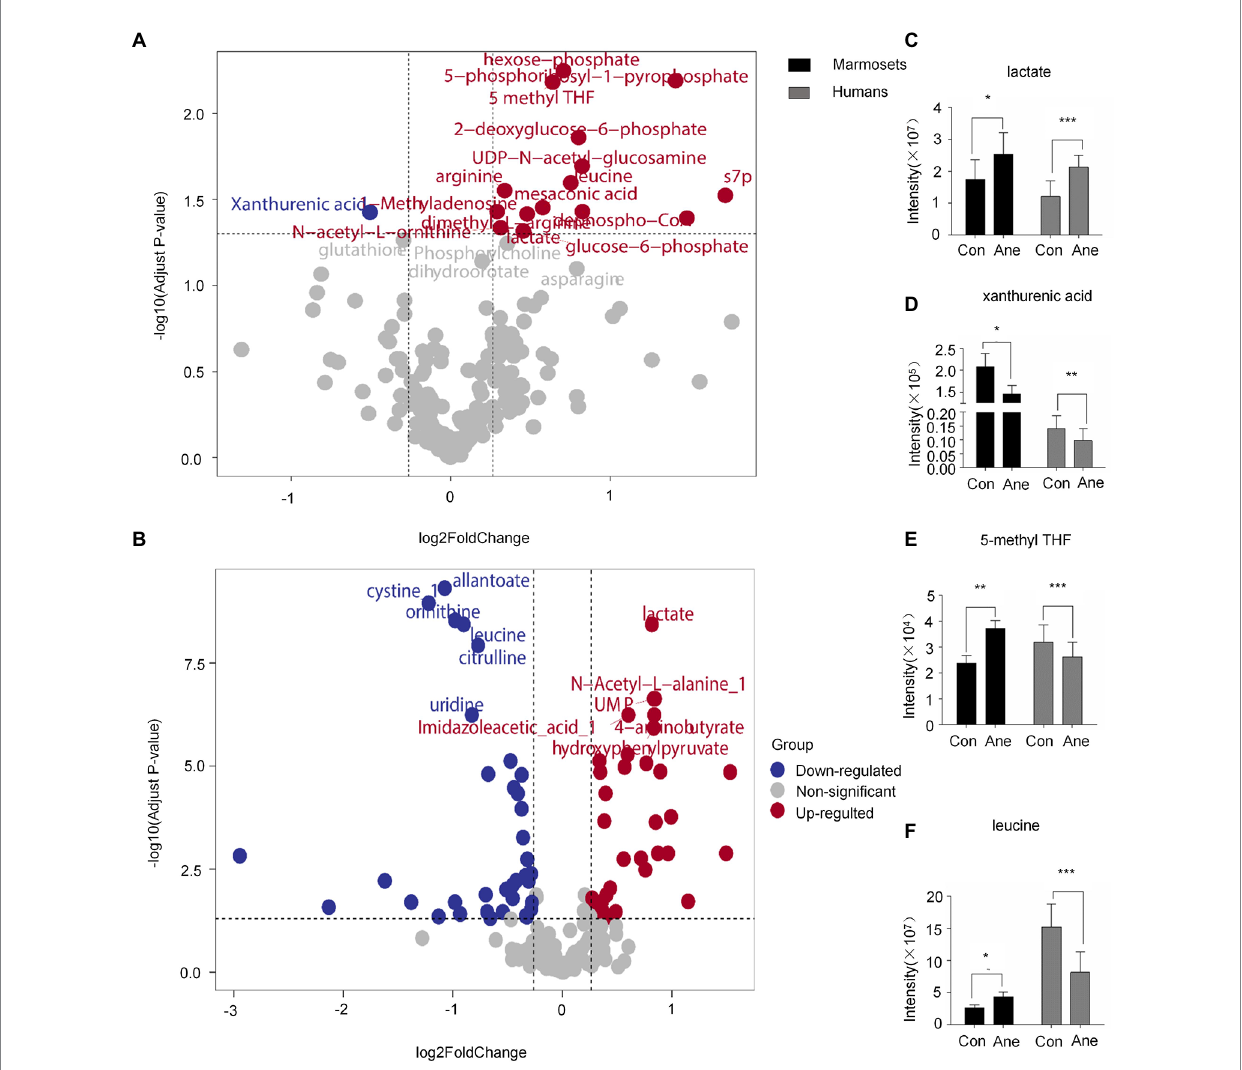
FIGURE 2 (A) and (B) Volcano plot of differential metabolite changes in marmoset monkey brain tissue and human serum after anesthesia, where the red dots indicate the metabolites that increased substantially in the anesthesia group compared with the control group (Fold Change >1.2, Raw p -value <0.05); Blue dots indicate metabolites that reduced significantly in the anesthesia group compared with the control group; Gray dots indicate metabolites that did not differ significantly in the anesthesia group compared with the control group (Fold Change <0.83, Raw p -value >0.05). (C–E) , and (F) Liquid chromatography–tandem mass spectrometry was used to detect the content of lactate, XA, 5-methyl THF, and leucine in the brain tissue of marmoset monkey and human serum. Sevoflurane anesthesia was defined as the anesthesia group, human preoperative serum as the control group, and postoperative serum as the anesthesia group. * p < 0.05 versus control; ** p < 0.01 versus control; *** p < 0.001 versus